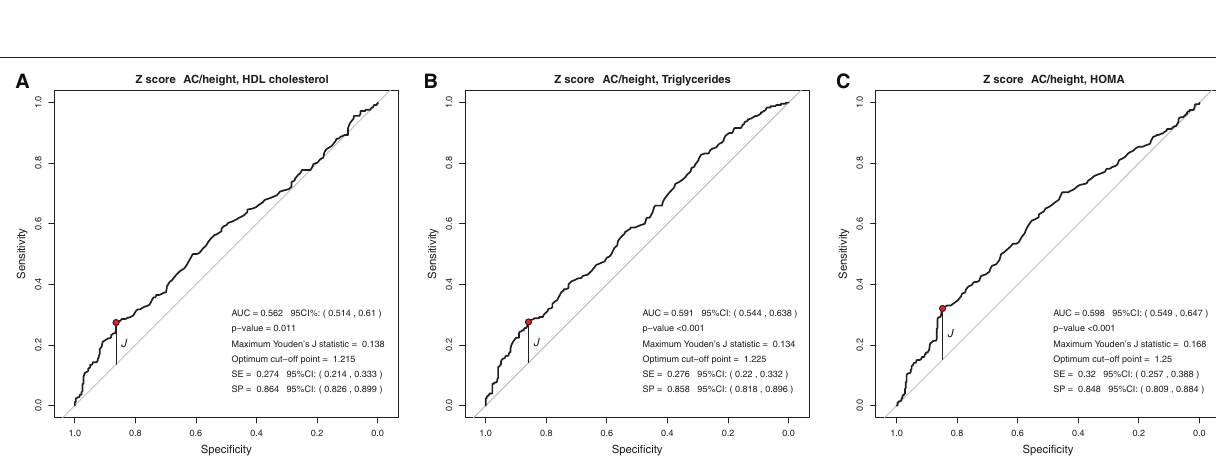
Z score AC/height, HDL cholesterol